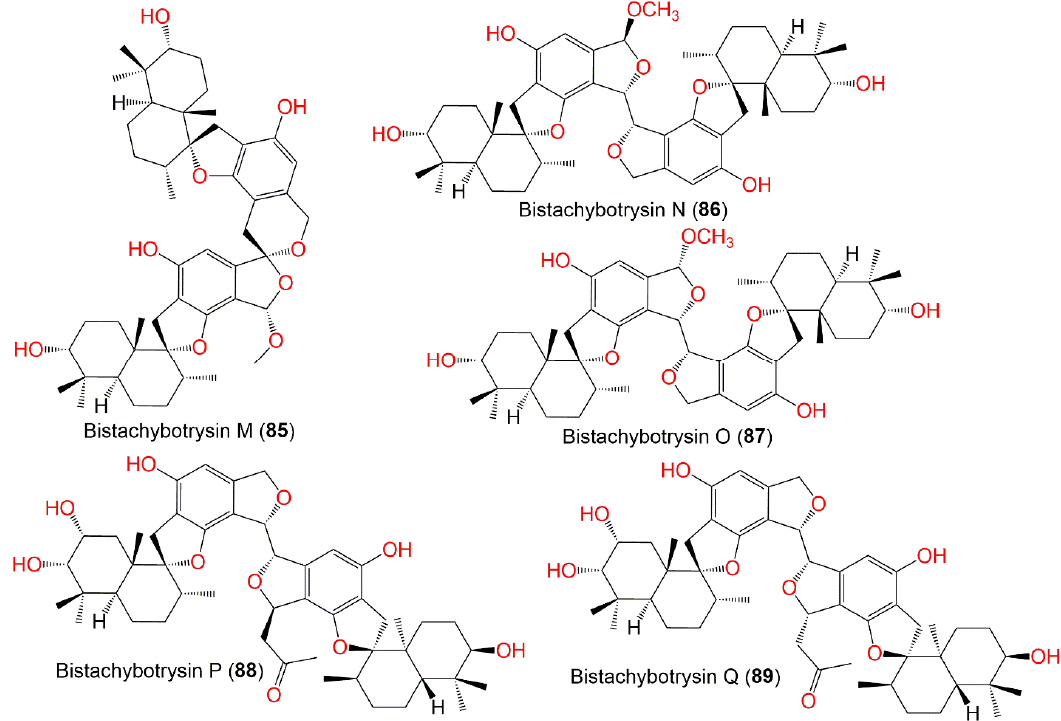
Figure 10. Structures of dimeric phenylspirodrimane derivatives ( 85 – 89 ) reported from S . chartarum .